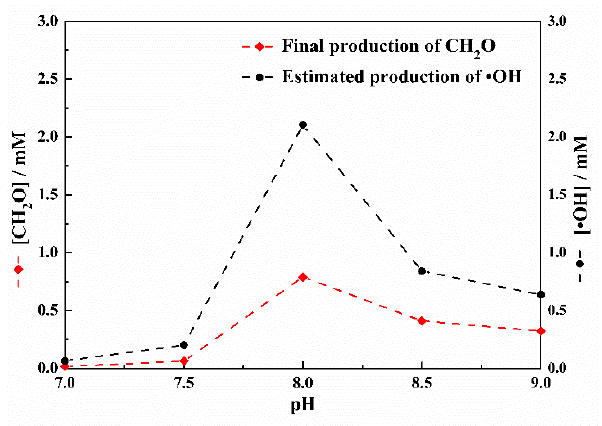
Figure 6. Final production of CH 2 O and estimated production of HO· as a function of pH. The final productions of CH 2 O were extracted from Figure 5. The estimated [HO·] = [CH 2 O]/Y and the yields (Y) were derived from a previous work [17].